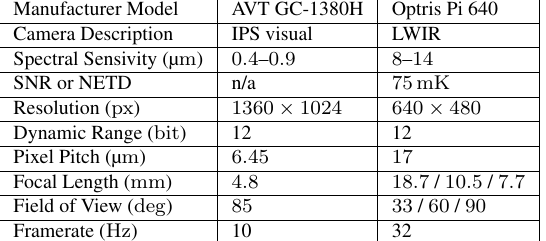
Table 1. Key specifications for the trifocal sensor systems. The LWIR camera comprises three different lenses.